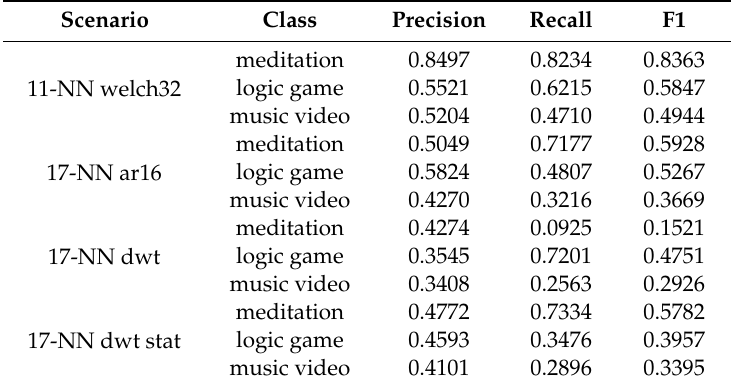
Table 6. Values of precision, recall, and F1 score for each signal class for chosen variants of Experiment